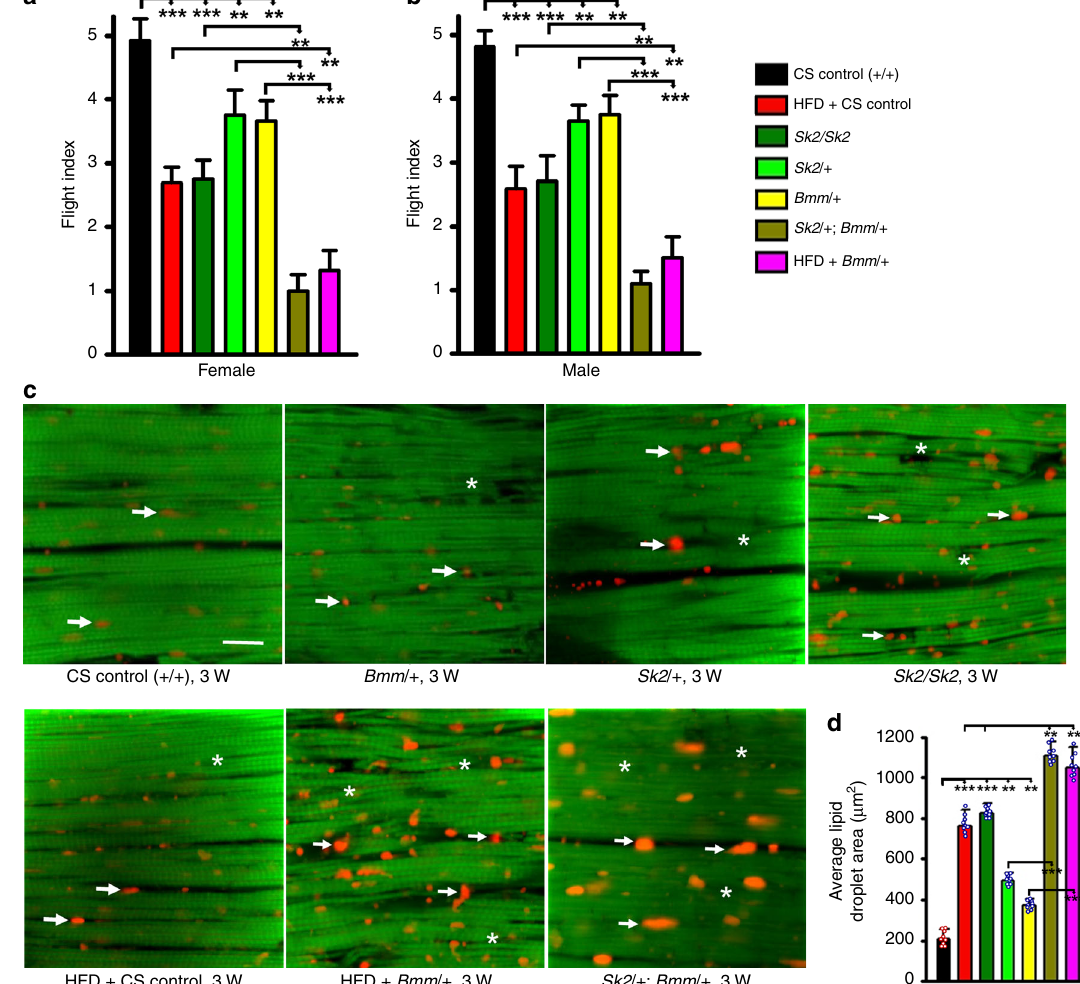
Fig. 4 ATGL ( Bmm )-mediated lipid turnover and regulation of obesity-induced muscle dysfunction. a – b Flight performance assay. Fly fl ight paths were recorded and given a numerical value to calculate fl ight index (F.I.) (see the Methods section). Muscle performance of each heterozygous mutant ( Bmm/ + and Sk2/ + ), homozygous mutant ( Sk2/Sk2 ), transheterozygotes mutant ( Sk2/ + ; Bmm/ + ), WT and Bmm/ + in the presence of HFD at the 3-week old in both male and female fl ies were signi fi cantly reduced compared with age-matched CS control ( + / + ). In addition, muscle performance of the transheterozygotes mutant ( Sk2/ + ; Bmm/ + ) mutant and HFD + Bmm/ + were found signi fi cantly reduced compared to each age-match heterozygous mutant ( Bmm/ + and Sk2/ + ) or homozygous mutant ( Sk2/Sk2 ) or HFD. ( n = 100 fl ies were tested at each genotype in both male and female fl ies from three independent experiments). c Confocal images of the IFM from 3-week-old females of wild-type ( + / + ) each heterozygous mutant ( Bmm/ + and Sk2/ + ), homozygous mutant ( Sk2/Sk2 ), and transheterozygotes mutant ( Sk2/ + ; Bmm/ + ) mutant, HFD + WT and HFD + Bmm / + probed with phalloidin (green) and Nile Red (red). More intramuscular lipid (arrows) and actin-containing myo fi brillar disorganization was detected in transheterozygotes mutant ( Sk2/ + ; Bmm/ + ) or HFD + Bmm / + (asterisks), compared with any other mutants or HFD + WT. Scale bar is 20 µ m. d Quanti fi cation of the intramuscular lipid area showed signi fi cant increase in each mutant compared to control and signi fi cantly elevated in transheterozygotes mutant ( Sk2/ + ; Bmm/ + ) or HFD + Bmm / + , compared with age-matched control, other mutants or HFD + WT. N = 9 images from three different for each genotype. For panels a , b , and d bar graphs (along with dot plots for panel d ) and error bars, presented as mean ± SD and statistical analysis was performed using one-way ANOVA with post hoc Tukey test, where * p < 0.05, 0.01 p < 0.01, *** p < 0.001, ns nonsigni fi